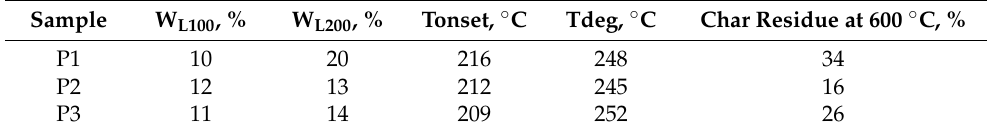
Figure 3. TGA/DTG of pectin-based cryogels. Table 3. Thermal properties of pectin monolith cryogels, where W L100 and W L180 present the weight loss at 100 ◦ C and 200 ◦ C, respectively, Tonset is the temperature at which starts degradation, and Tdeg is the temperature of maximum degradation